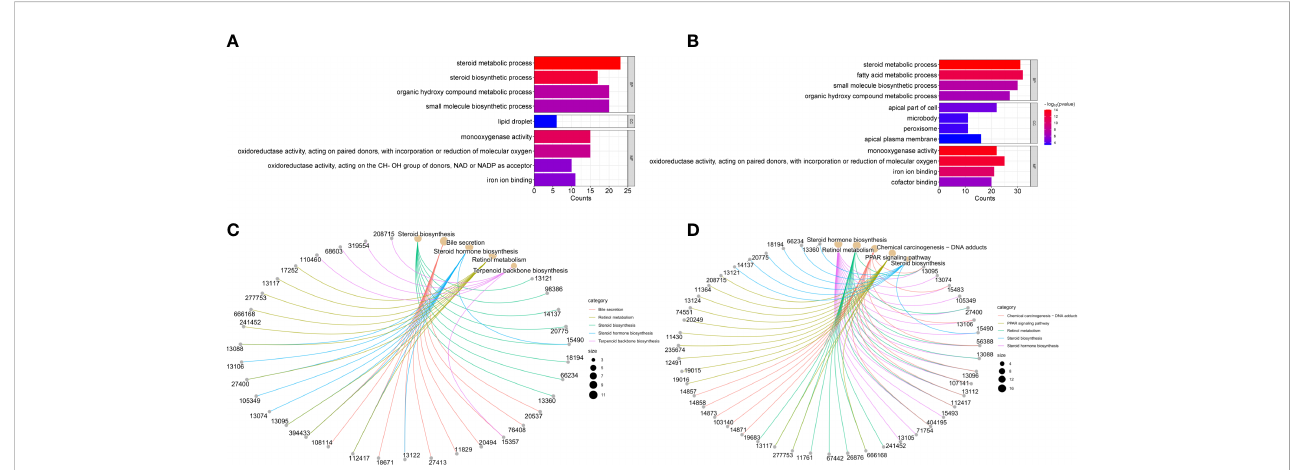
FIGURE 7 GO and KEGG enrichment analysis of hepatic DEGs in the CS271011 3 mg/kg group and MGL-3196 3 mg/kg group. (A) GO classi fi cation of DEGs (CS3 vs. D); (B) GO classi fi cation of DEGs (M3 vs. D); (C) KEGG classi fi cation of DEGs (CS3 vs. D); (D) KEGG classi fi cation of DEGs (M3 vs. D). D, DIO control